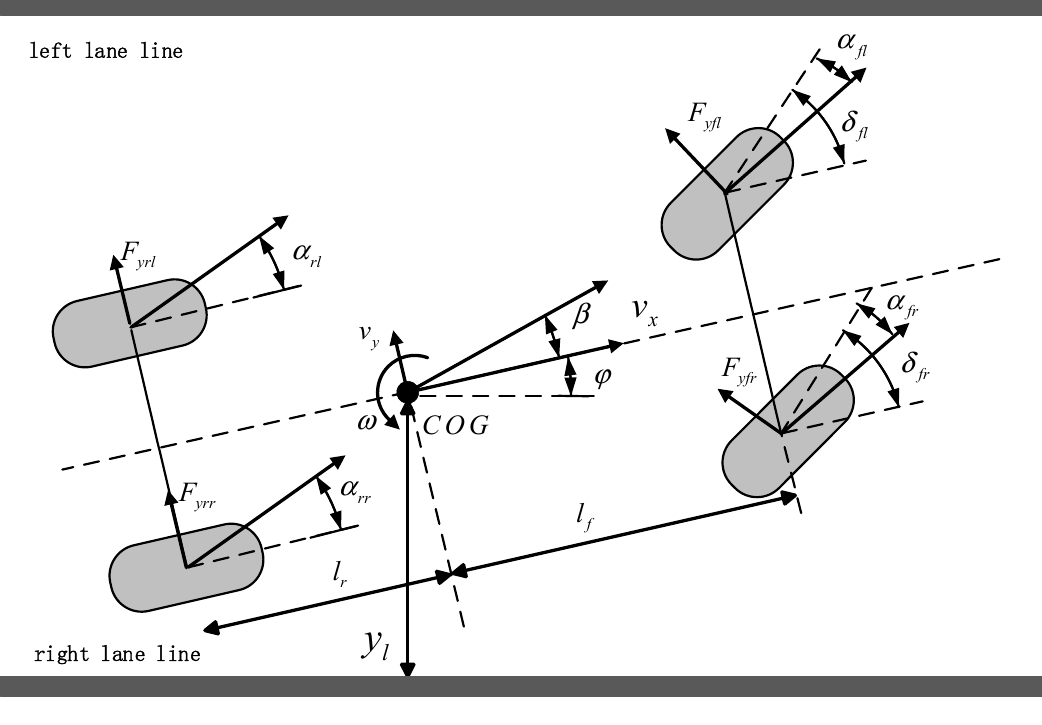
Figure 1. Vehicle Figure 1. Vehicle model.